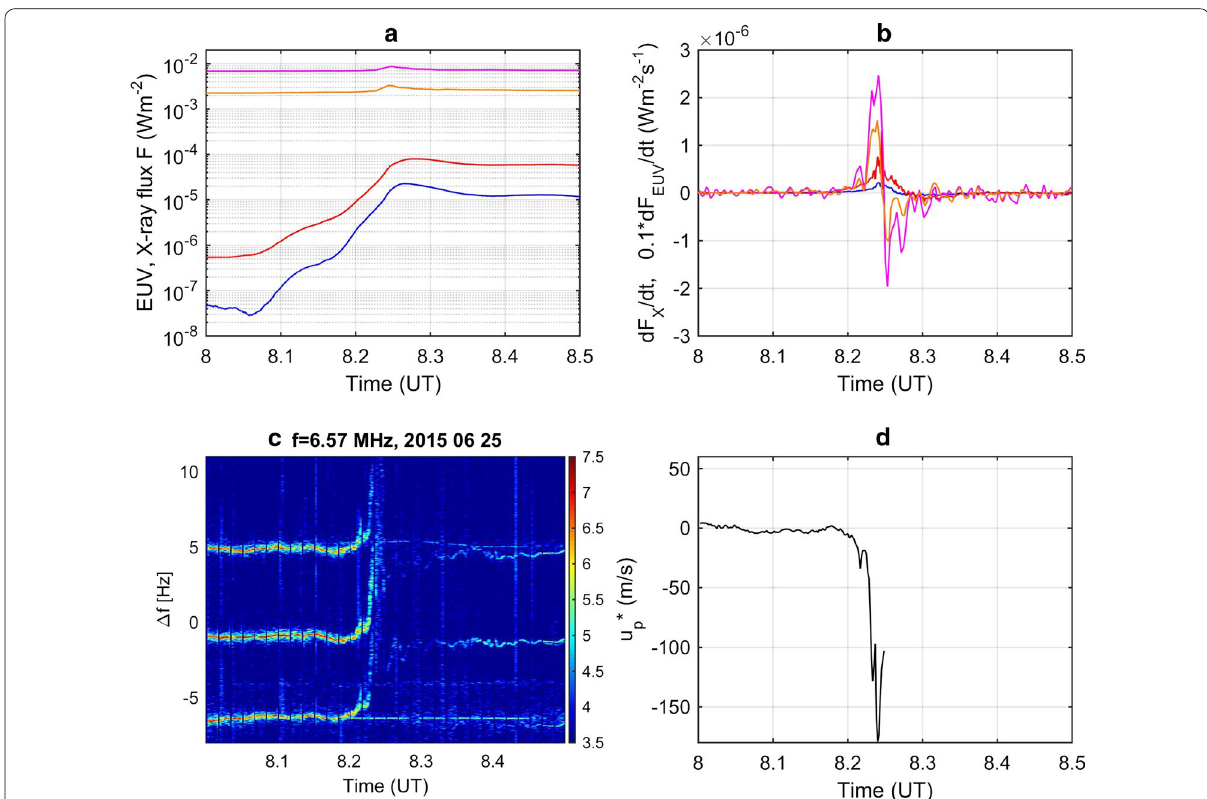
Fig. 8 X‑ray event on 25 June 2015 and its ionospheric response. a X‑ray fluxes in the ranges 0.1–0.8 nm and 0.05–0.4 nm by red and blue, respectively, EUV (lyman H alpha) flux by magenta and EUV flux in the range 25–35 nm by orange recorded from 08:00 to 08:30 UT. b Time derivatives of the X‑ray fluxes, dF X /dt, (red for 0.1–0.8 nm, blue for 0.05–0.4 nm) and 0.1 the 25–35 nm channel (orange). c Spectrogram recorded by CDSS in Taiwan from 08:00 to 08:30 UT. d Virtual plasma velocity u P* obtained by Eq. (3) for f 6.57 =